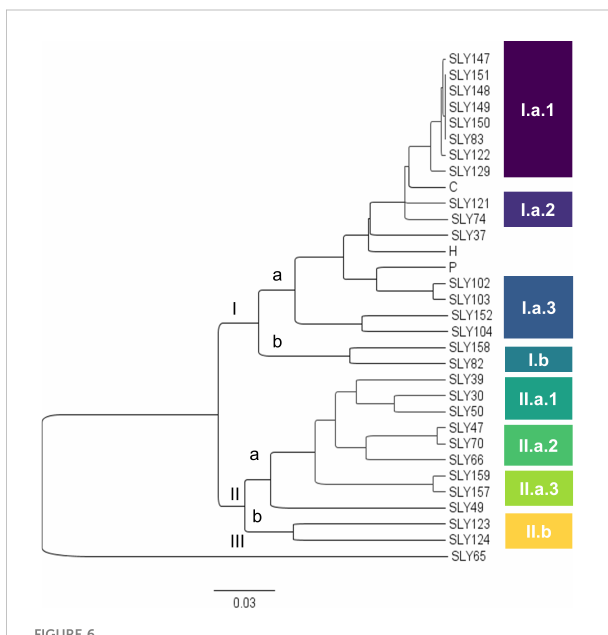
FIGURE 6 Nei ’ s distance genotypic dendrogram with UPGMA